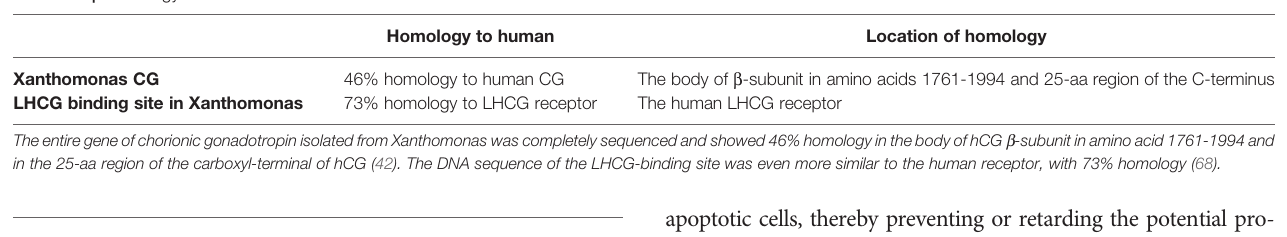
TABLE 3 | Human CG vs microbial CG (Xanthomonas and Candida Chorionic Gonadotropin). Molecular Weight